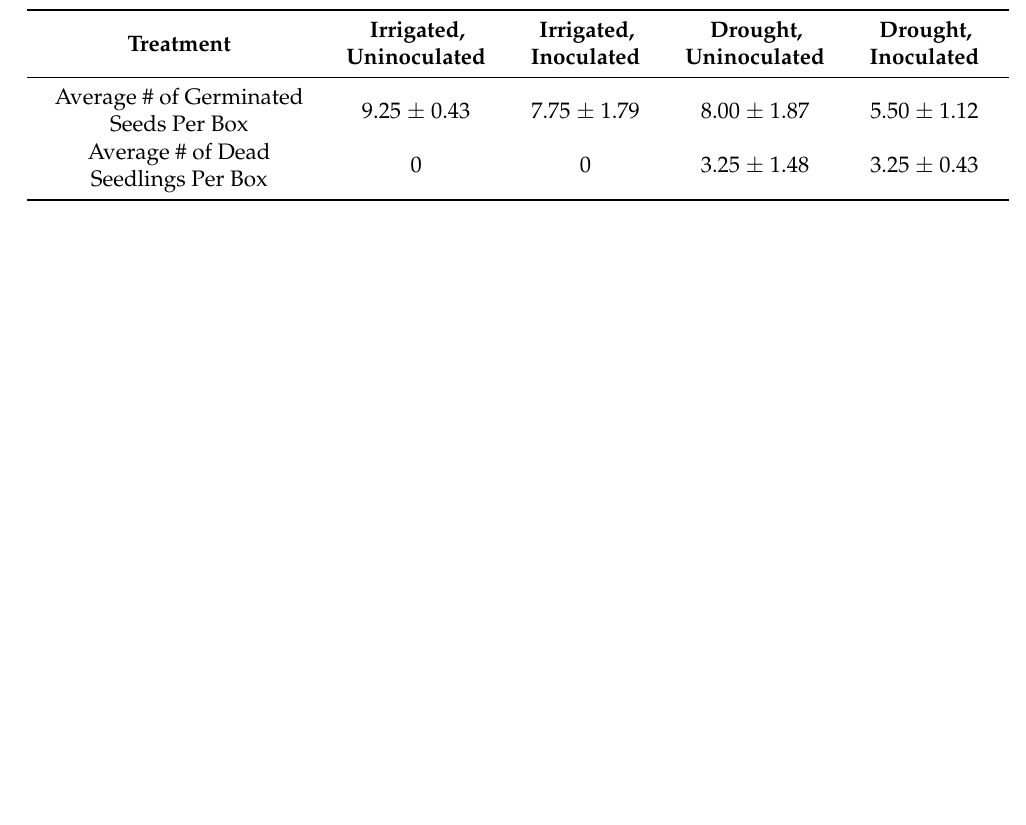
Table A2. Average number of wheat seeds germinated per magenta box by treatment. Each box contained a total of 10 seeds. ± refers to standard